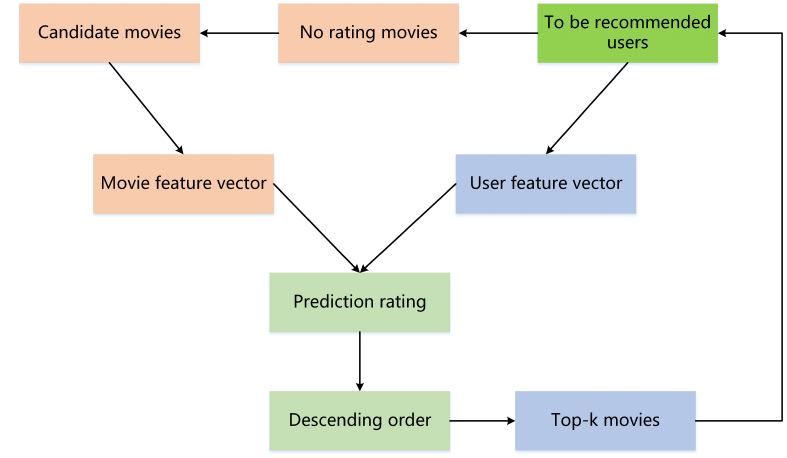
Figure 10. Scheme 1 recommended strategy diagram.